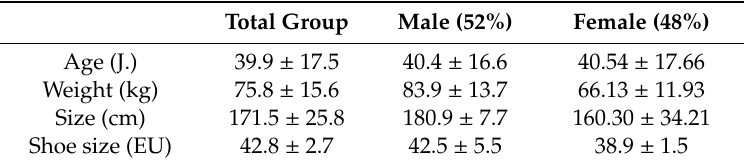
Table 1. Anthropometric data of the volunteers, broken down by